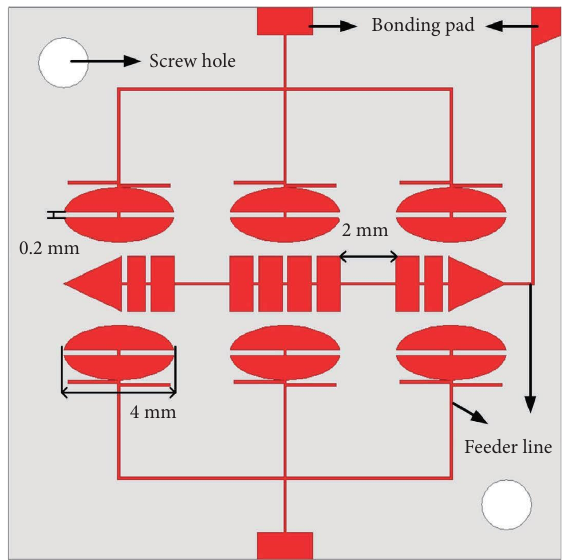
Figure 5: Te bias electrode network.